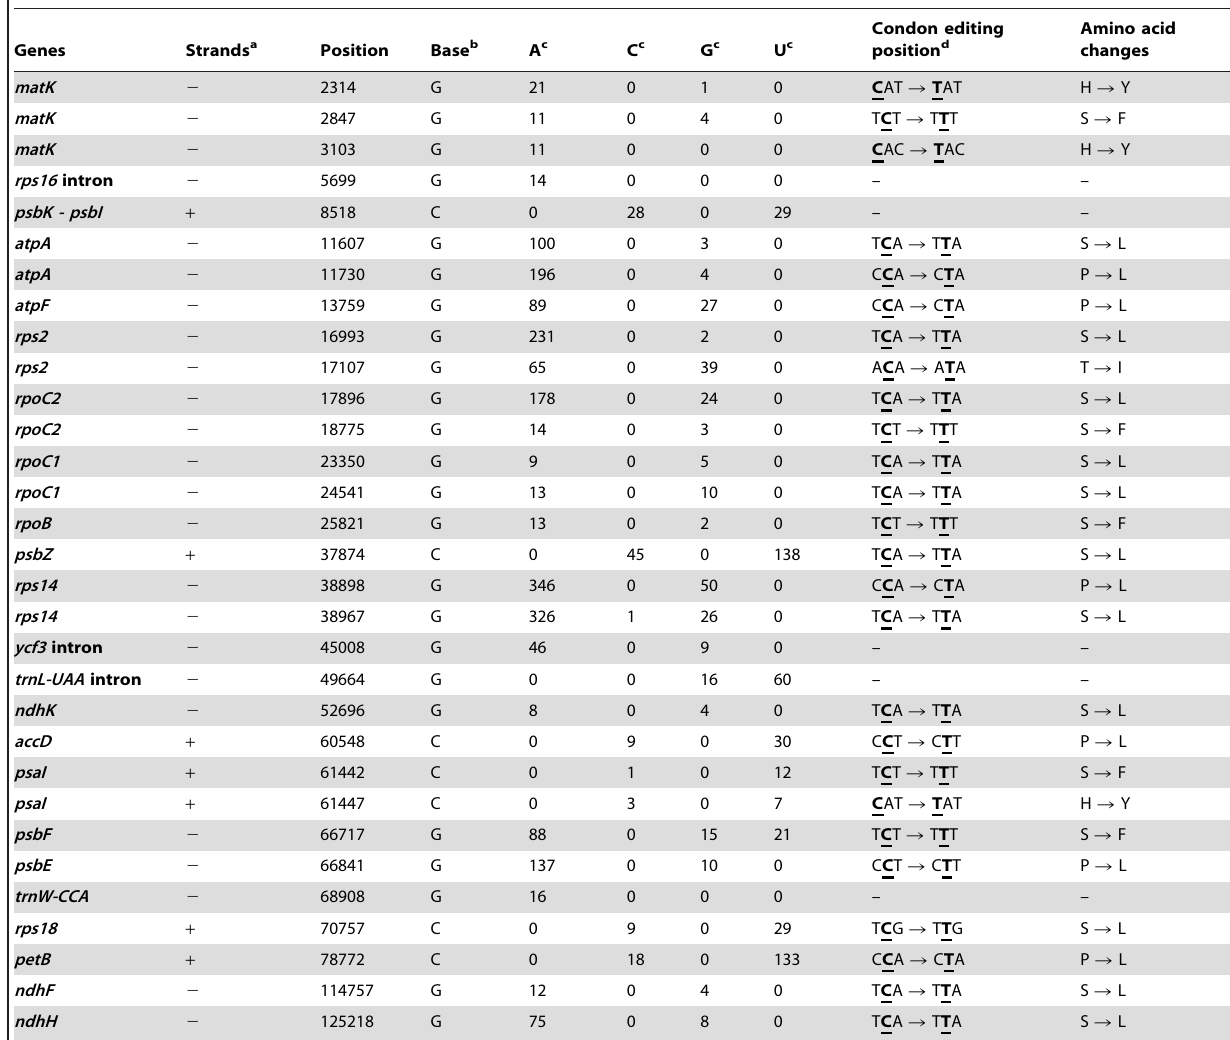
Table 2. RNA editing detected by transcriptome reads